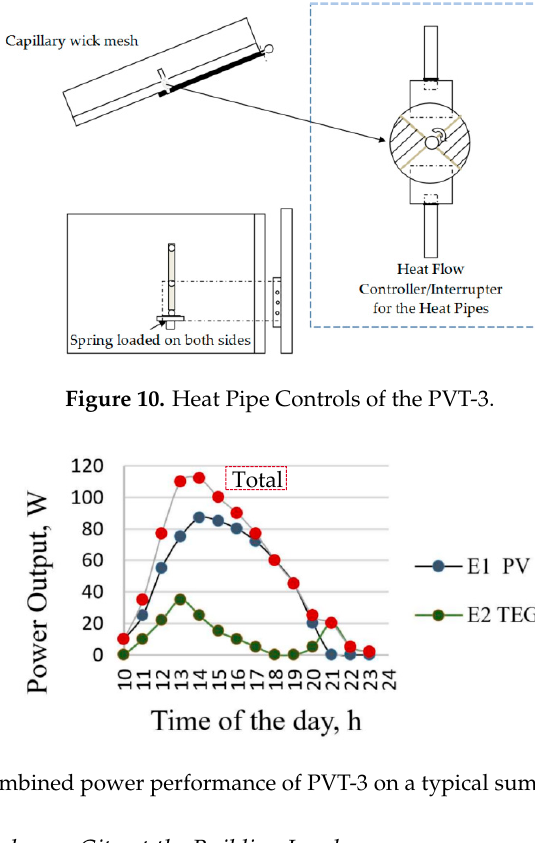
Figure 9. Experimental Set-up. (Photo courtesy of Var ı ş l ı and Aydo ğ an).